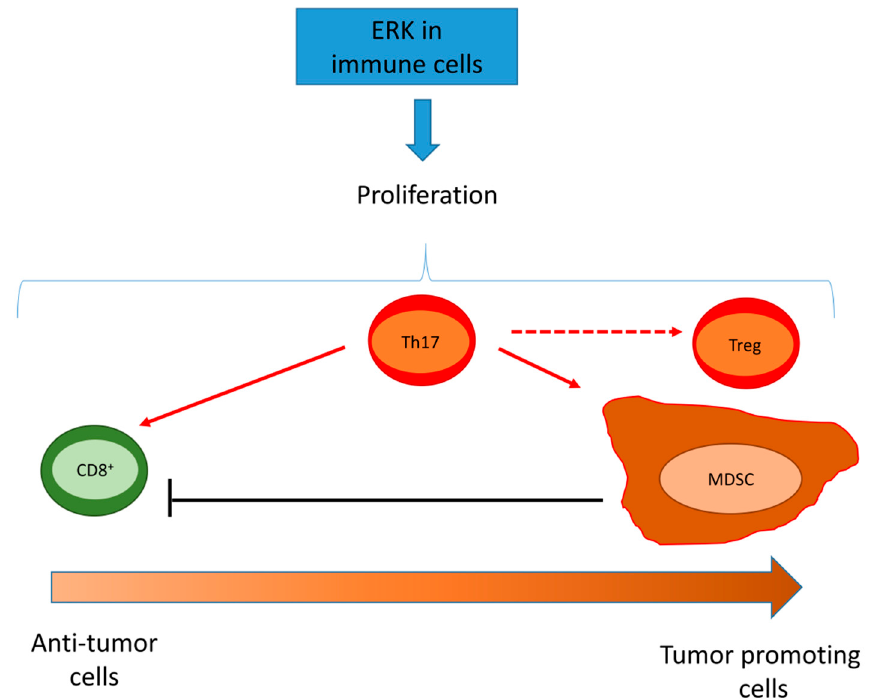
Figure 3. Effects of ERK activation in tumor infiltrating cells. ERK induces the proliferation of anti-tumor immune cells, such as CD8 + T-lymphocytes, immune-suppressive cells, such as myeloid derived suppressor cells (MDSC) and T-regulatory (Treg) cells, and cells that have either pro-tumor or anti-tumor activities, such as T-helper 17 (Th17) cells. Th17 cells can promote the pro-inflammatory phenotype of CD8 + T-lymphocytes, differentiate into cells with a Treg phenotype, and expand MDSCs that induce apoptosis of CD8 + T-cells. Depending on the type of immune-population characterized by high ERK activity, a wide range of effects (ranging from an anti-tumor to a tumor tolerant/immune-suppressive environment) is obtained. Dashed arrows indicate a direct activation by Th17 cells; the dotted arrow indicates the product of a differentiation of Th17 cells.